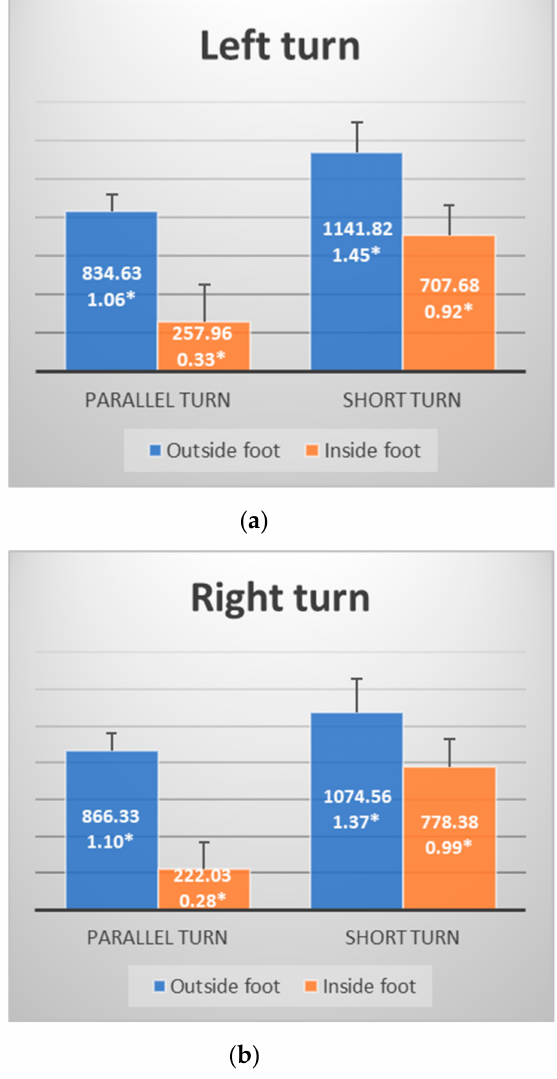
Figure 3. ( a ) pressure forces in the left turn expressed in Newtons and mean body weight (marked with *); ( b ) pressure forces in the right turn expressed in Newtons and mean body weight (marked with